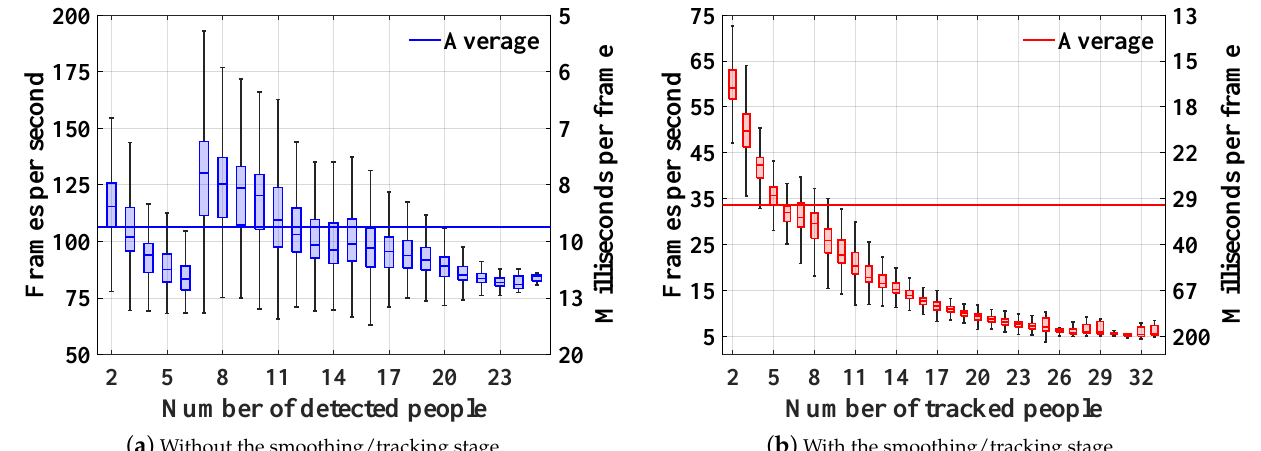
Figure 9. The computational complexity analysis results in terms of frame and processing rates. The proposed approach is tested with and without the smoothing/tracking stage. The results are grouped by the number of detected/tracked